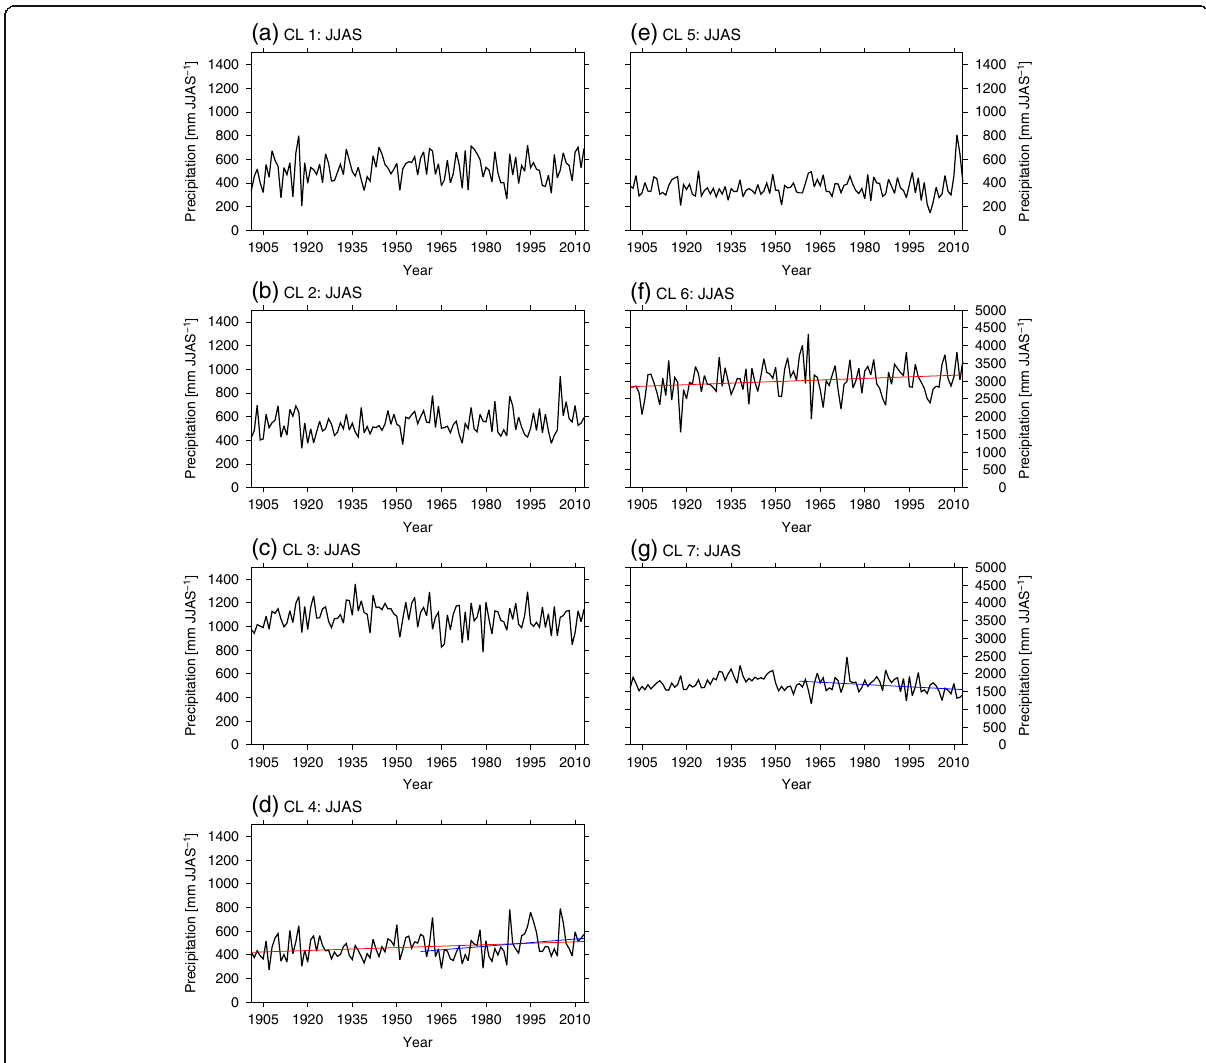
Fig. 4 Secular variation of summer monsoon precipitation for each cluster. Time series of JJAS precipitation averaged in CL1 ( a ), CL2 ( b ), CL3 ( c ), CL4 ( d ), CL5 ( e ), CL6 ( f ), and CL7 ( g ). The straight line shows the regression of the long-term trend at the 5% significance level for 1901 – 2013 (red) and 1958 – 2013